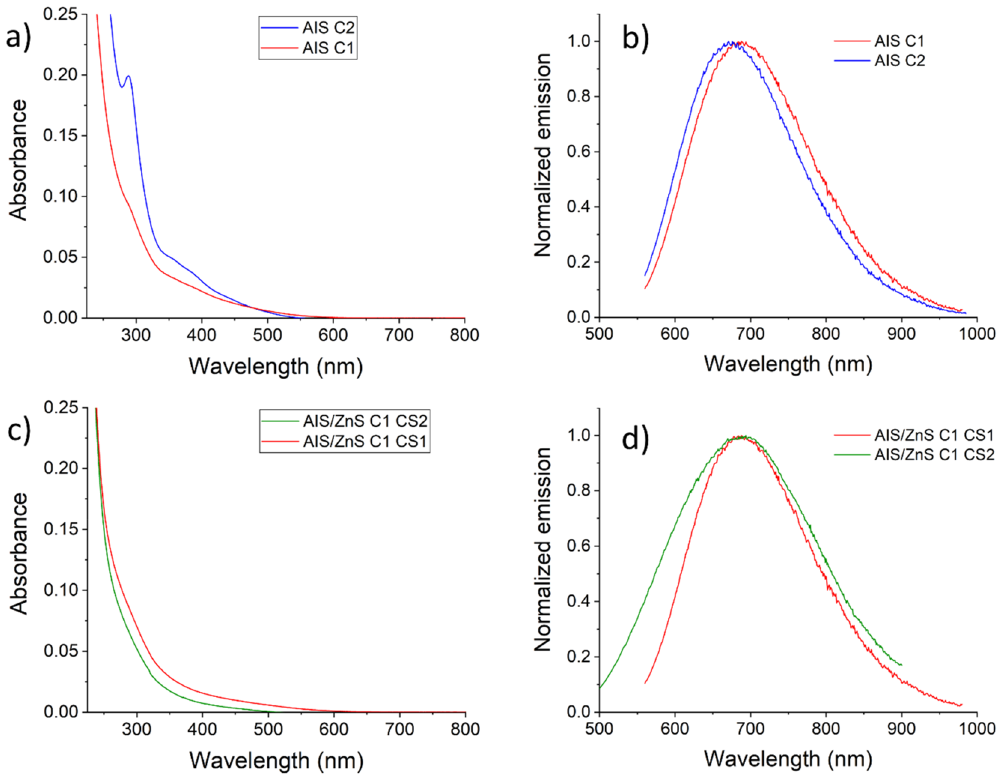
Figure 3. Absorption spectra and normalized emission spectra of AIS core QDs ( a , b ) and of Zn treated AIS/ ZnS QDs ( c , d ) synthesized with method C1 (red) or C2 (blue) for core QDs and C1-CS1 (red) and C1-CS2 (green) for Zn treated